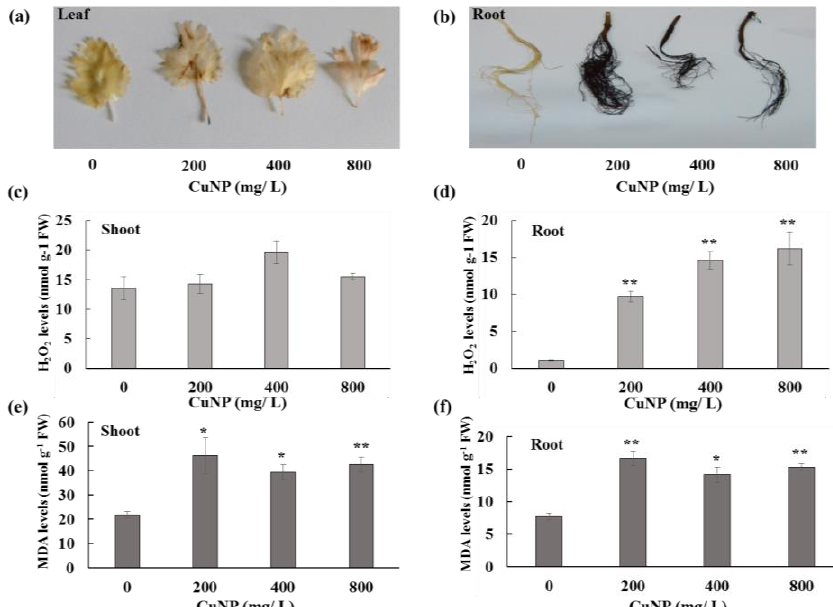
Figure 3. H 2 O 2 and MDA content analysis of C. sativum plants after 7 days of exposure to 200, 400 and 800 mg/L of CuNPs. ( a ) DAB staining as a preliminary test for detection of H 2 O 2 in shoots and ( b ) roots. ( c ) H 2 O 2 levels in shoots and ( d ) roots. ( e ) MDA levels in shoots and ( f ) roots. The values are mean ± se ( n = 3). Statistically significant difference was calculated at * p ≤ 0.05, ** p ≤ 0.01.